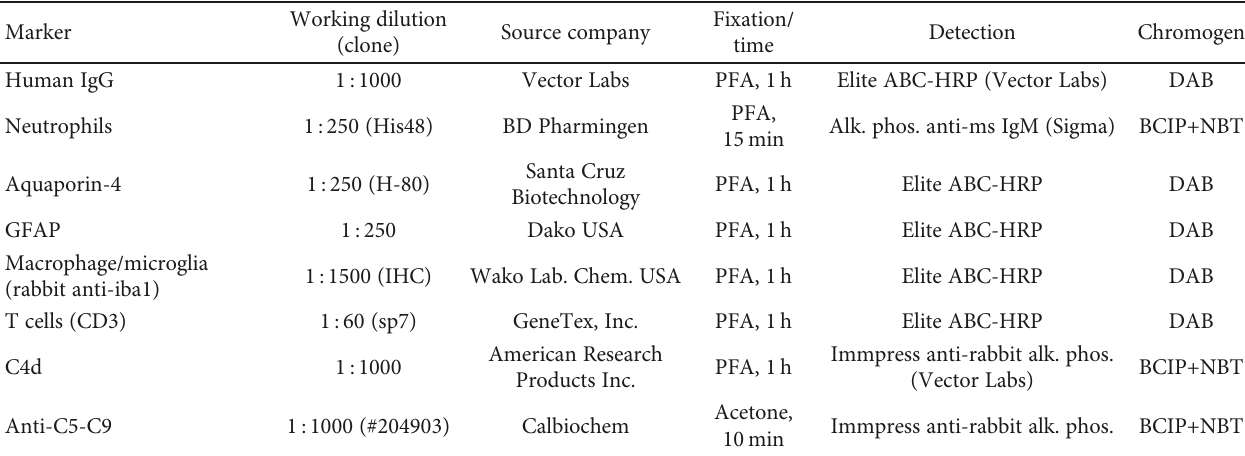
Table 1: Immunohistochemistry